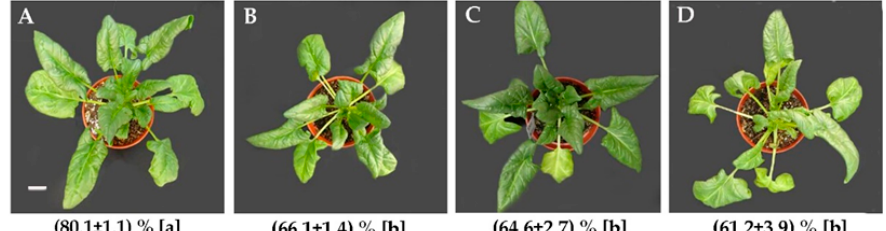
Figure 1. Morphology and relative water content (RWC) in spinach variety Sp73 under heat stress. Leaves were withered and the leaf RWC was decreased after 24 h of heat treatment (HHT) of 37 °C/32 °C (day/night). ( A ) 0 HHT; ( B ) 24 HHT; ( C ) 48 HHT; and ( D ) 72 HHT. Underneath each morphological image is the leaf RWC expressed as mean ± standard deviation (SD) ( n = 3). Small letters (a, b) in the brackets indicate significant difference among different treatments ( p < 0.05). Bar= 2.9 cm.